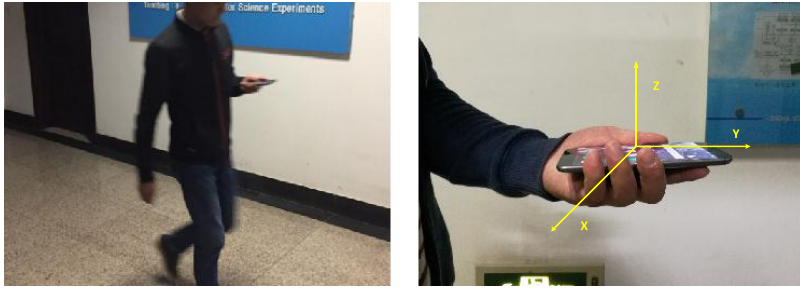
Figure 10. Attitude of the smartphone and the pedestrian’s gesture in the